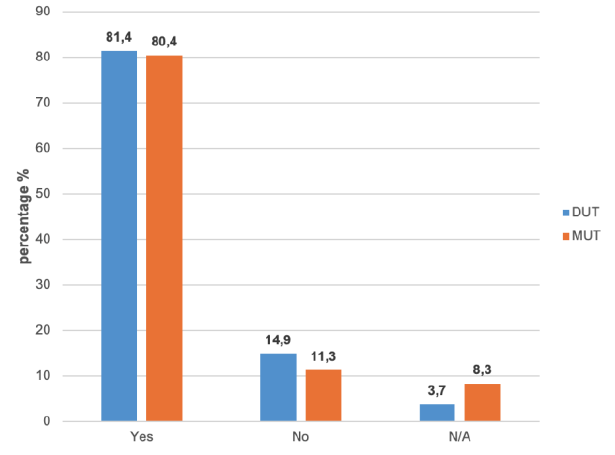
Figure 3: Familiarity of DUT/MUT